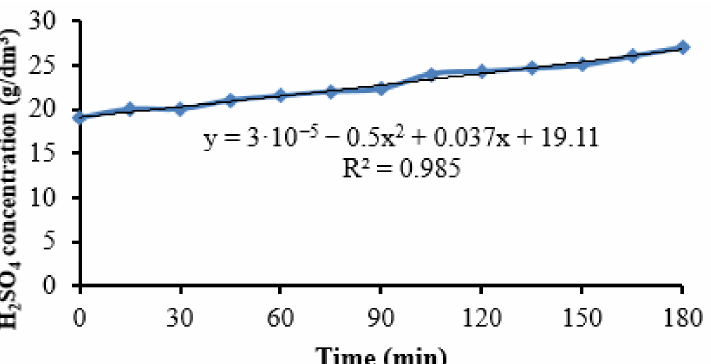
Figure 10. Change in the concentration of H 2 SO 4 during electrooxidation in the flow electrolyzer (solution without preliminary precipitation of